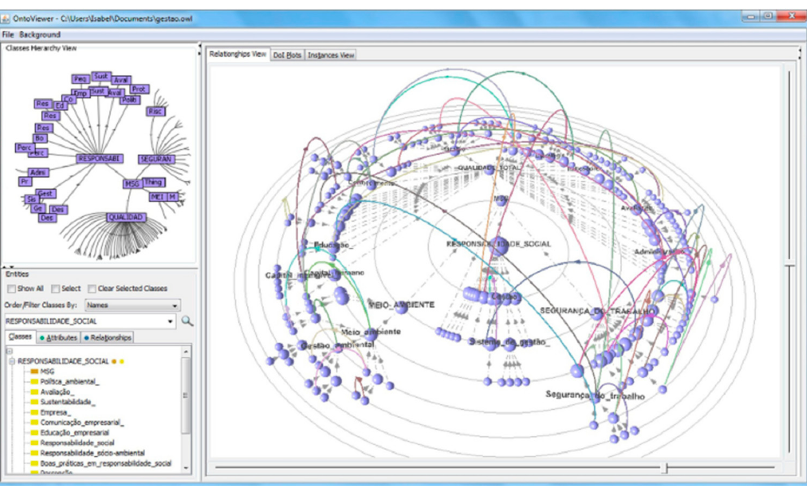
Figure 6. OntoViewer: List, overview, and relations context subviews. Source: Image with permission courtesy of “Visualization and analysis of schema and instances of ontologies for improving user tasks and knowledge discovery”, School of Informatics, UniRitter Laureate International